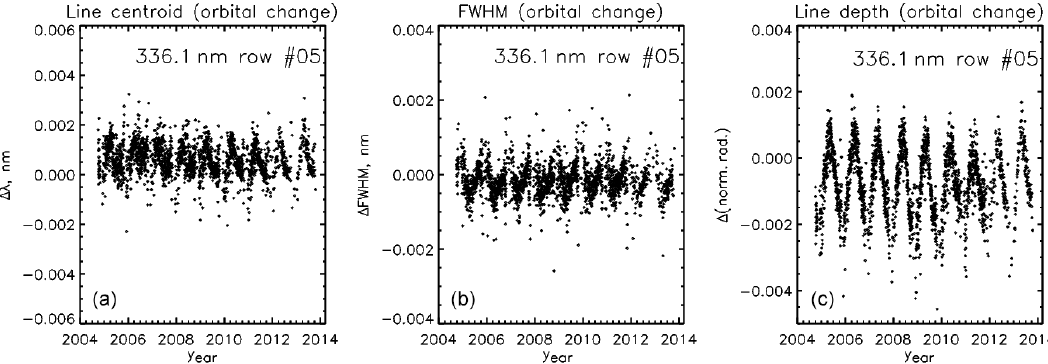
Figure 35. The orbital changes of the line centroids (a) , line FWHMs (b) and line depths (c) in the UV2 radiances for the spectral blend at 336.1nm and the row 5. These trends are representative for all